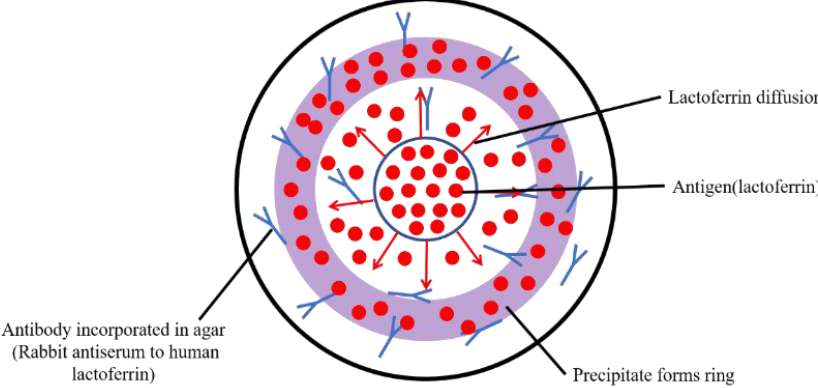
Figure 1. Scheme of radial immunodiffusion. Lactoferrin from the center would conjugate with its antibody and diffuse along the agar, and the area of the ring reflects its concentration.